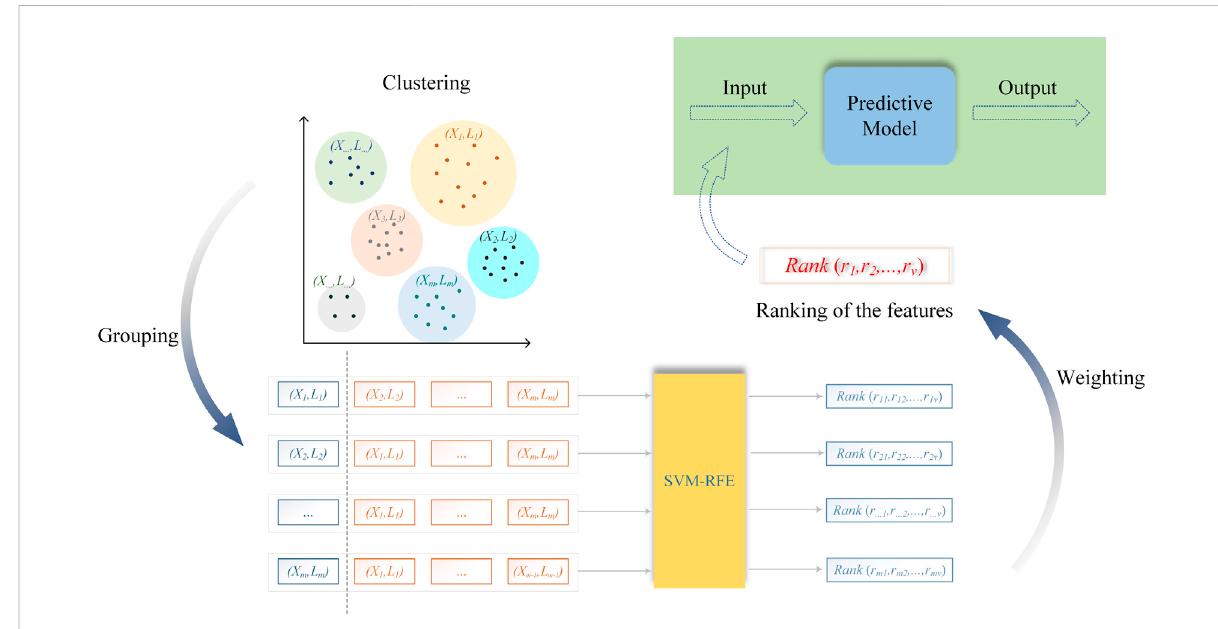
FIGURE 2 SVM-RFE combined with clustering algorithm for sequential feature